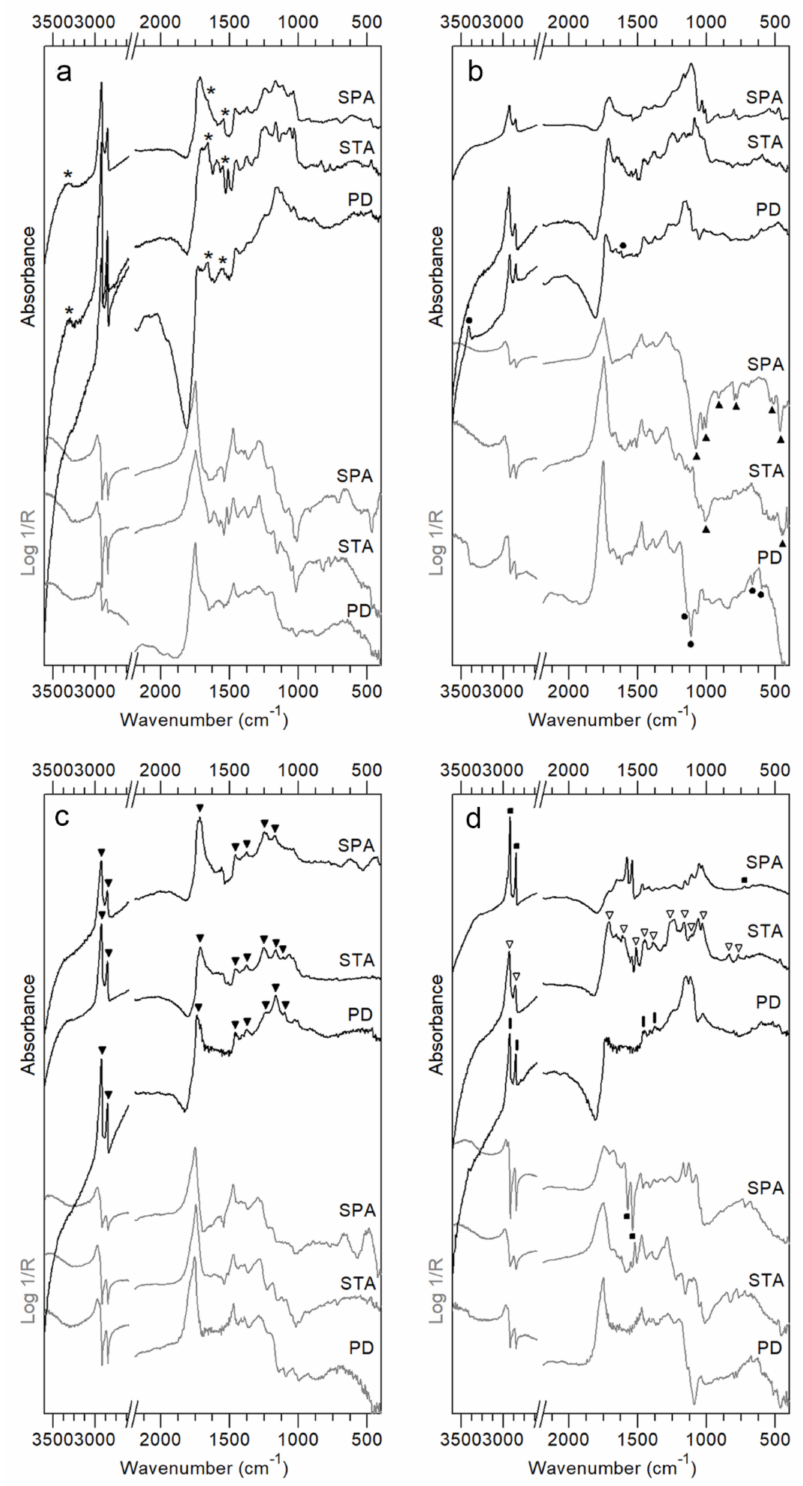
Figure 3. Reflection FTIR spectra in pseudo-absorbance (gray line) and after KKT (black line) collected in areas of the three violins (SPA—“Spagnoletti”, STA—“Stauffer”, PD—“Principe Doria”) containing: ( a ) proteins, ( b ) inorganic compounds, ( c ) varnishes, and ( d ) restoration substances. Marker bands of proteins ( ∗ ), silicates ( (cid:78) ), sulfates ( (cid:108) ), varnishes ( (cid:72) ), metal soap ( (cid:110) ), benzoin resin ( (cid:53) ), and aliphatic hydrocarbon ( (cid:120) ) are